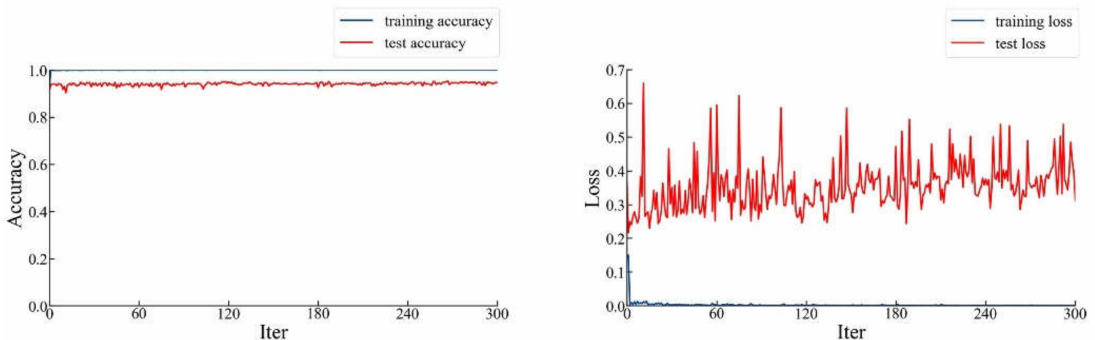
Figure 11. The accuracy and loss curve of the ResNet-101 + FPN in the first step.